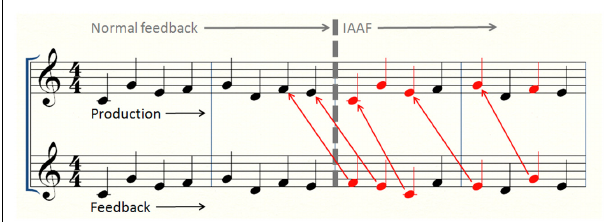
FIGURE 2 | Music notation for the first two repetitions (out of five) of melody 1. The top row displays production, the bottom row displays feedback, and the gray barrier indicates the transition from normal feedback to 16-event AAF. Red notes are altered to a lag-2 serial shift of